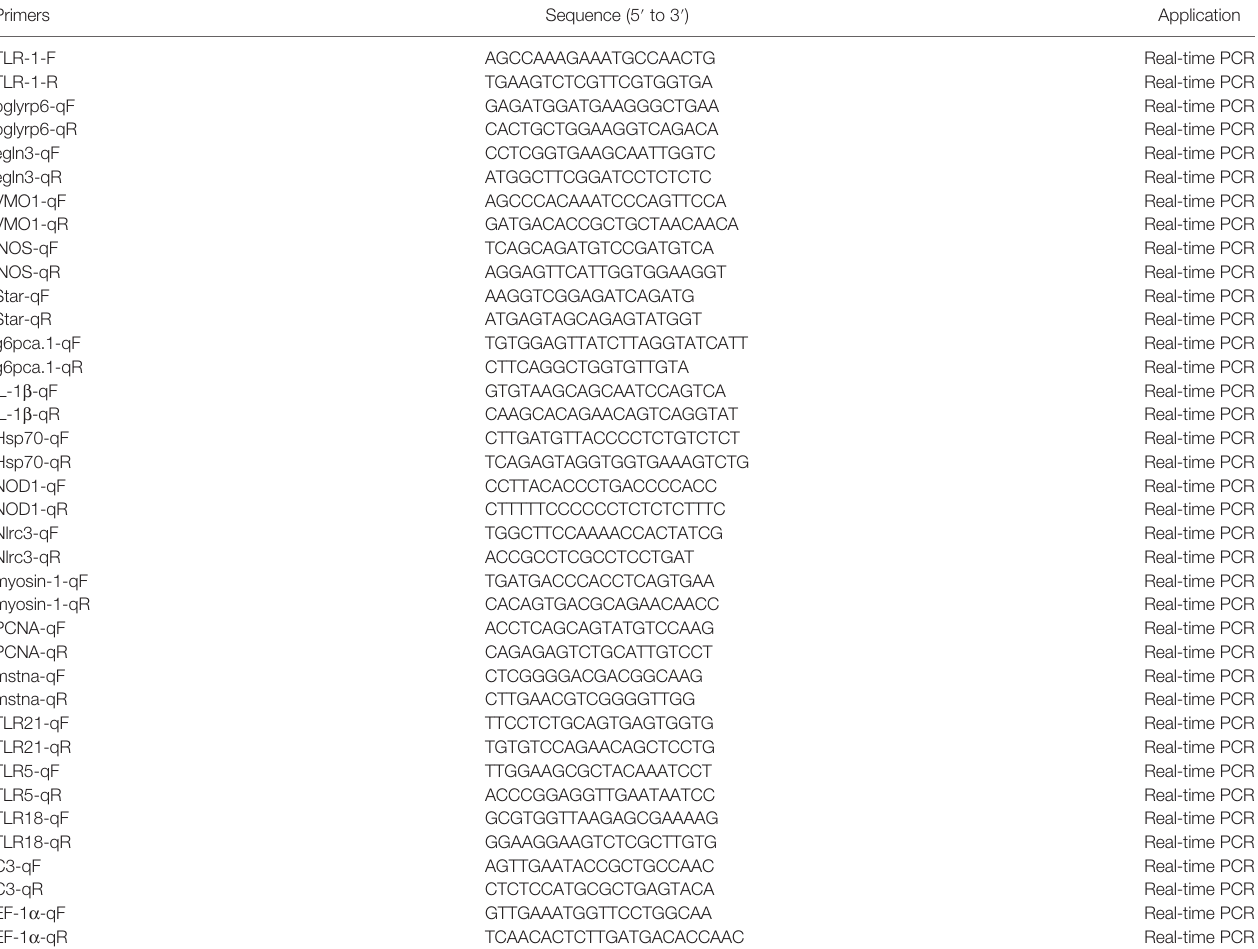
TABLE 1 | Primers used in qRT-PCR for DEGs validation.